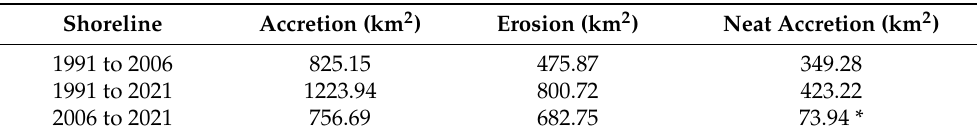
Figure 14. Cumulative accretion and erosion of lands in the coastal region of Bangladesh (shoreline to shoreline): ( a ) 1991 to 2006, ( b ) 1991 to 2021, and ( c ) 2006 to 2021. Table 2. Changes in accession and erosion of lands along shorelines.